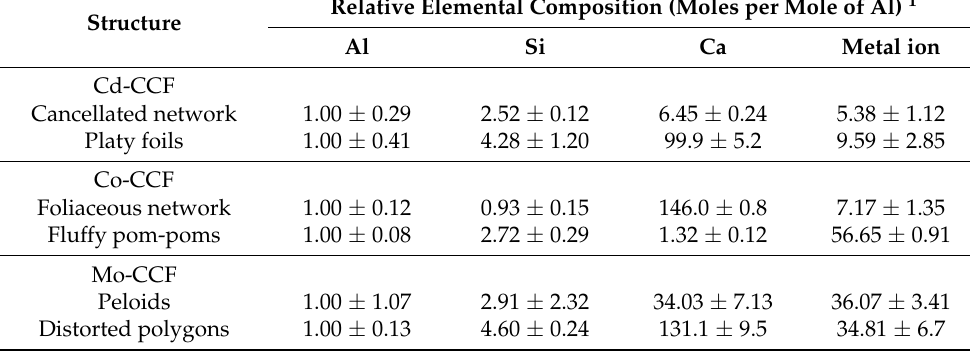
Table 4. Composition of metal-bearing structures on the surface of CCF.